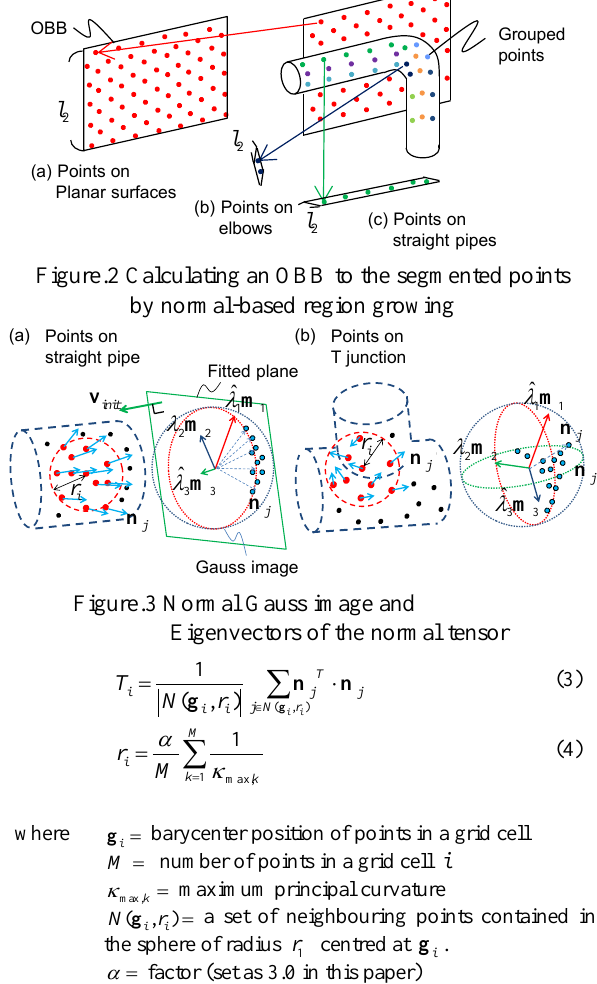
Figure.3 Normal Gauss image and Eigenvectors of the normal